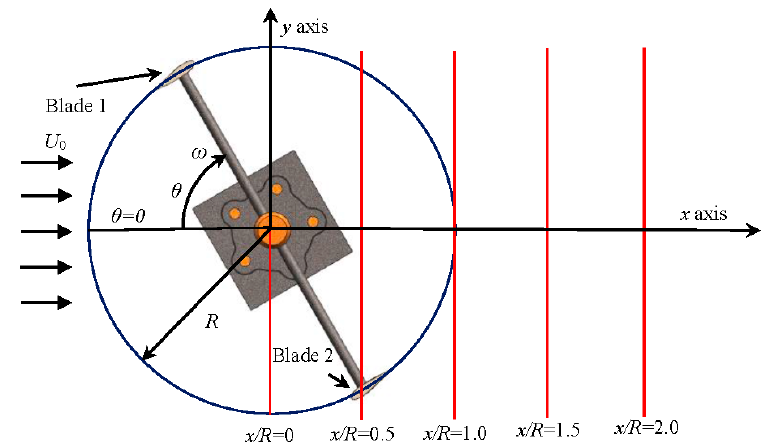
Figure 2. Top view of VAWT and measured positions of the wind velocity along the longitudinal direction of the rotor. The five red lines represent the measured positions of x/R = 0, 0.5, 1.0, 1.5 and 2.0, respectively.